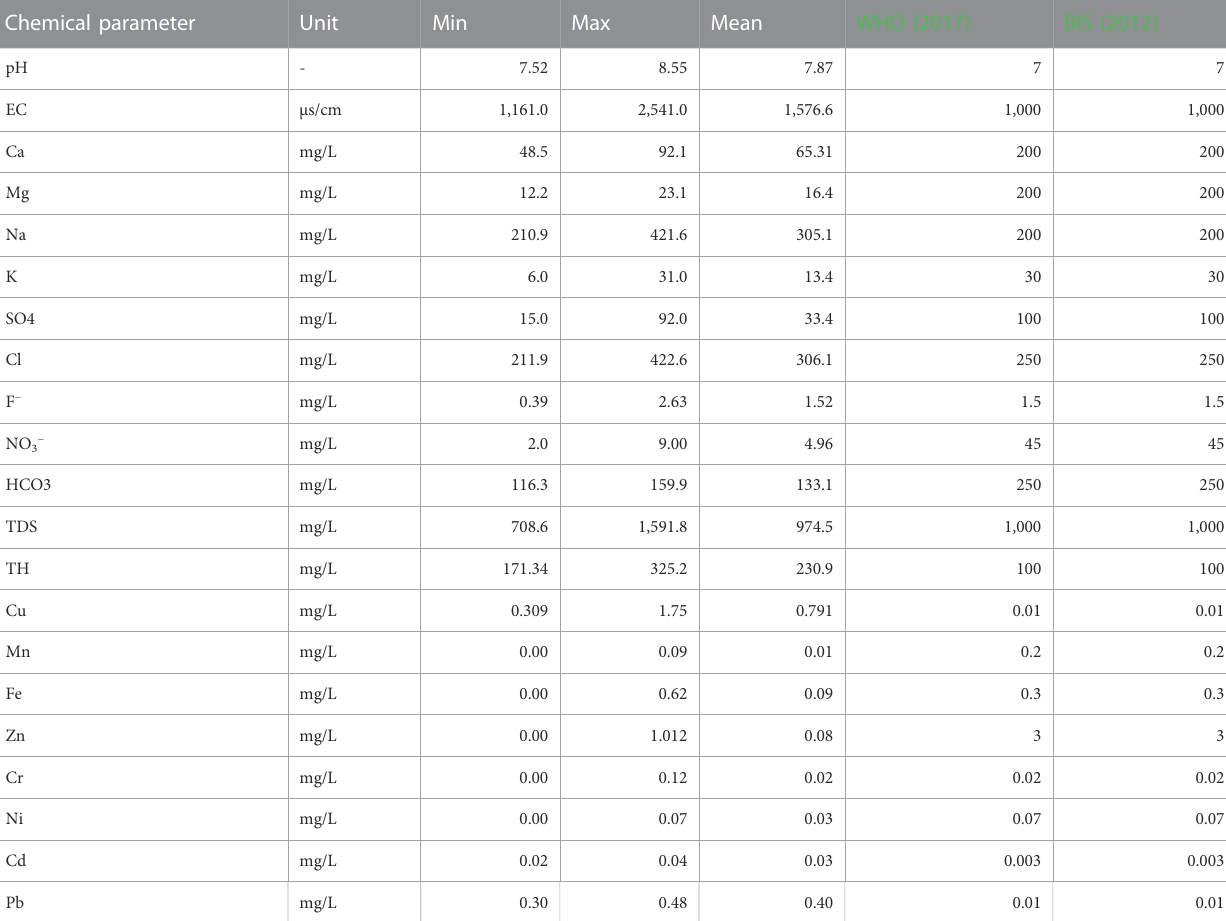
TABLE 3 Descriptive statistical summary of the physicochemical parameters compared to quality standard. Chemical parameter